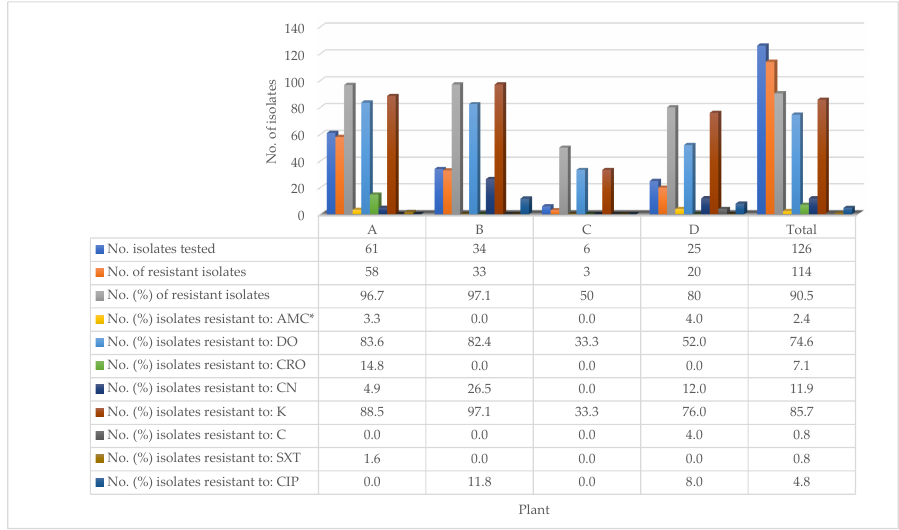
Figure 2. Antimicrobial resistance of Salmonella isolates isolated from four processing plants. * AMC, amoxicillin-clavulanic acid (30 µ g); DO, doxycycline (30 µ g); CRO, ceftriaxone (30 µ g); CN, gentam- icin (10 µ g); K, kanamycin (30 µ g); C, chloramphenicol (30 µ g); SXT, sul-famethoxazole-trimethoprim (23.75 and 1.25 µ g); CIP, ciprofloxacin (5 µ g). 3.8. Frequency of Antimicrobial Resistance of Salmonella Isolates Based on the Type of Sample The frequencies of resistance to antimicrobial agents (Table 6) were similar amongst the various types of samples, ranging from 86.2% to 100% in chilled chicken parts, post- evisceration carcasses, chilled whole carcasses, neck skins, pre-evisceration carcasses, chiller water, and cloacal swabs. The frequency of resistance to DO was significantly ( p = 0.045) higher for isolates of Salmonella that originated from pre-evisceration carcasses (23/25, 92.0%) compared with isolates from other types of samples. The differences in the frequency of resistance were not statistically significant ( p > 0.05) for Salmonella isolated from the other types of samples other than from chiller water samples. Table 6. Antimicrobial resistance of Salmonella isolated from various stages of processing. Stage in